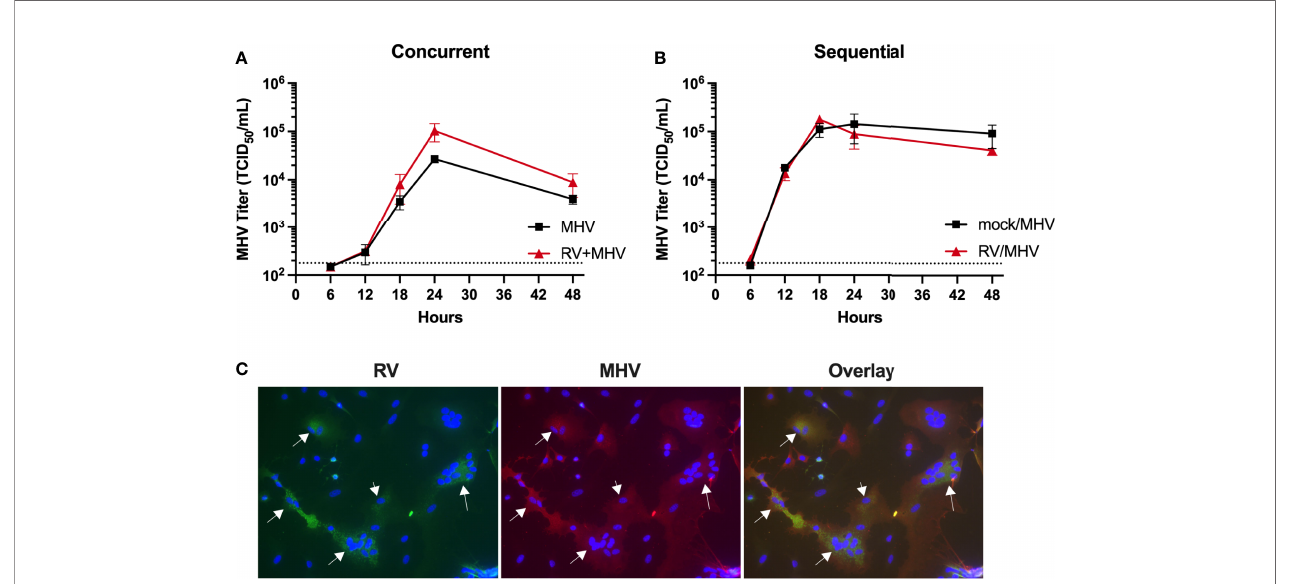
FIGURE 6 | RV does not inhibit MHV-1 replication in a coinfected epithelial cell line. LA4 cells were inoculated with (A) RV and MHV-1 concurrently or (B) RV 6 hours before MHV-1. Supernatant media from triplicate samples per time point were titrated for MHV-1 by TCID 50 assay using 17Cl.1 cells. (C) LA4 cells were inoculated with RV and MHV-1 concurrently, and viral antigens were labelled by IFA 18 hours later. Antibodies against RV were detected with Alexa488 (green) and MHV-1 with Alexa555 (red) and nuclei were labelled with DAPI (blue). The panels show RV (green), MHV-1 (red), and overlay of both images. White arrows show examples of coinfected cells containing both RV and MHV-1